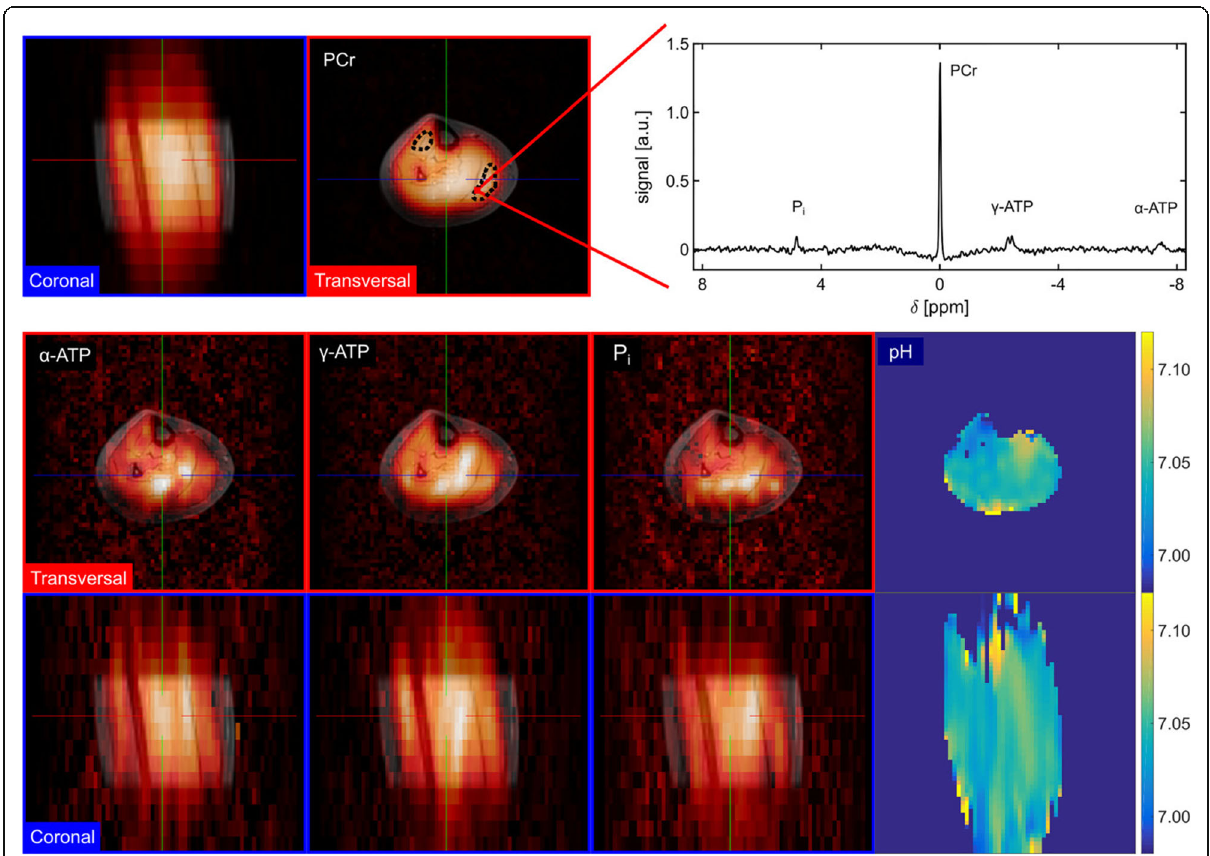
Fig. 7 Three-dimensional in vivo 31 P – { 1 H} echo planar spectroscopic imaging dataset from the human calf muscle. The shown 31 P – { 1 H} spectrum was localised in a voxel inside the medial gastrocnemius muscle (indicated by bold red line; effective size 4.05 mL). Transversal and coronal metabolic maps superimposed on 1 H images of Phosphocreatine (PCr), α - and γ -adenosine triphosphate (ATP), inorganic phosphate (Pi), and pH are displayed. The position of transversal and coronal slices is indicated by the thin red and blue lines, respectively. Absolute intensity scales of α - and γ -ATP, Pi are cropped for better visualisation. The PCr maps were used to create a mask for the corresponding pH maps. Regions for evaluation of signal-to-noise and metabolite ratios are illustrated by the black dashed lines. For the measurement parameters and the acquisition strategy see the reference article ’ s text. Reprinted with permission from: Korzowski et al., Magn Reson Med 2018 (reference